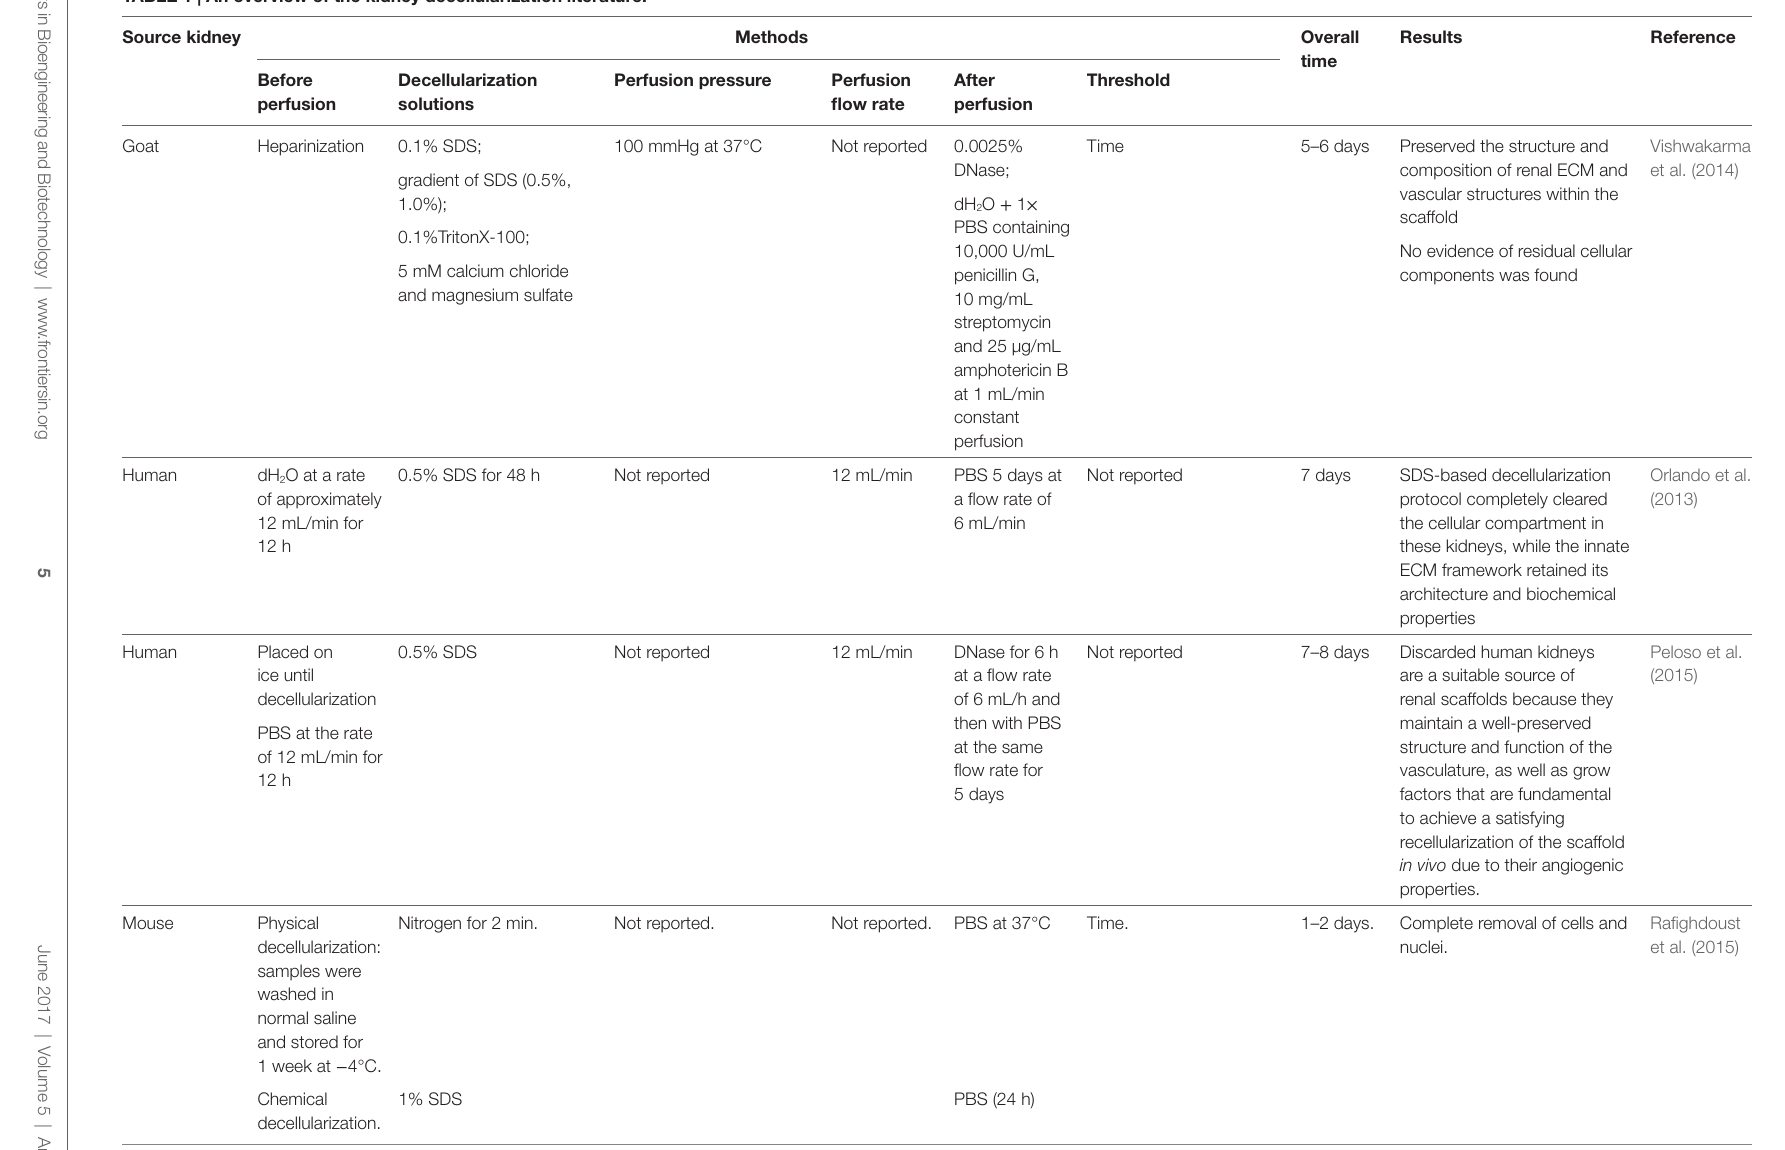
TABLe 1 | An overview of the kidney decellularization